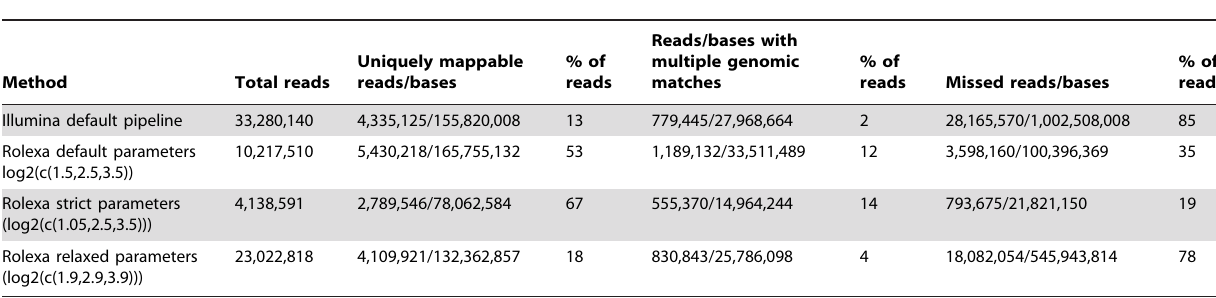
Table 1. Number of sequence reads extracted from intensity files using Illumina and Rolexa analysis.